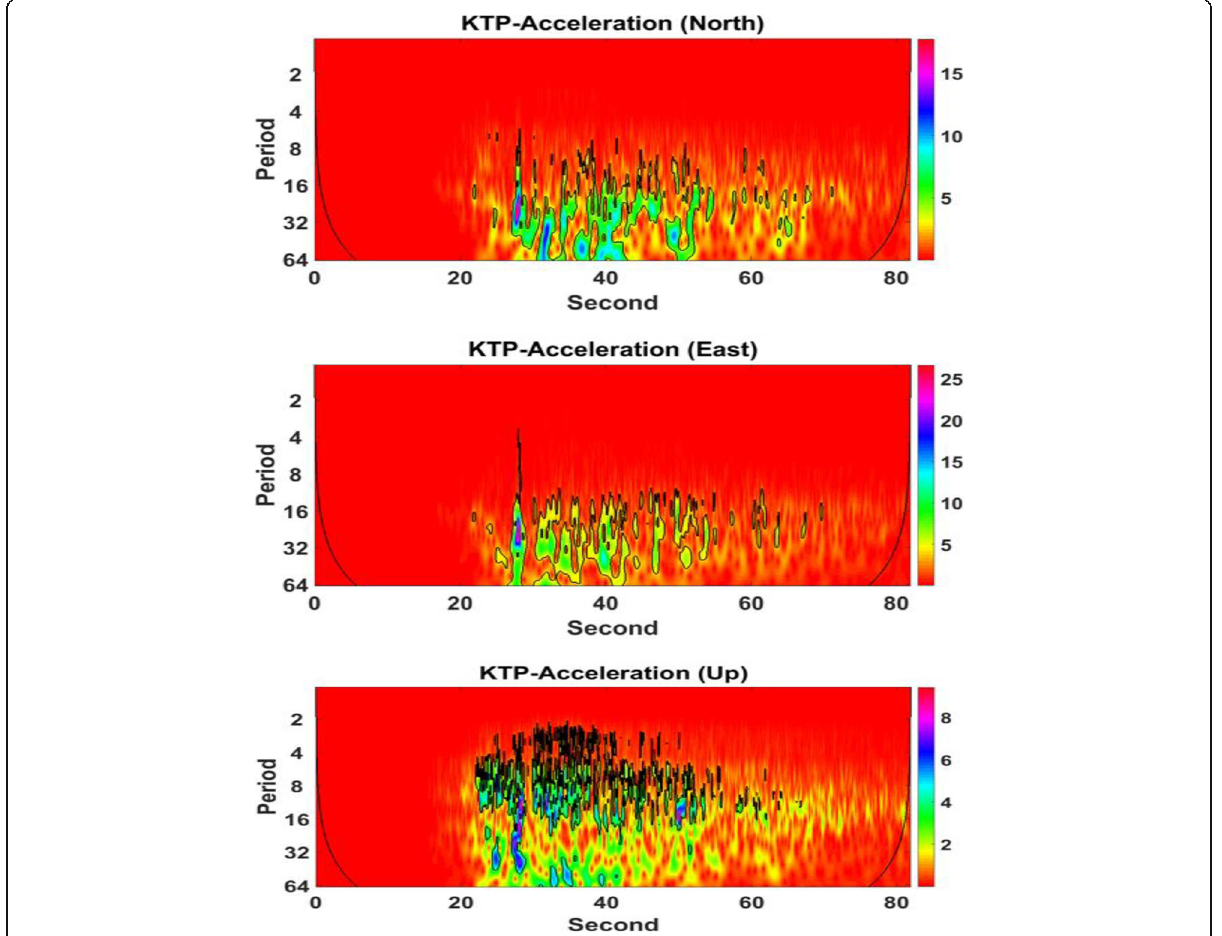
Fig. 10 Two Dimension CWT-Scalogram ground motion from NS, EW, and Vertical record (0 – 80 s) at KTP